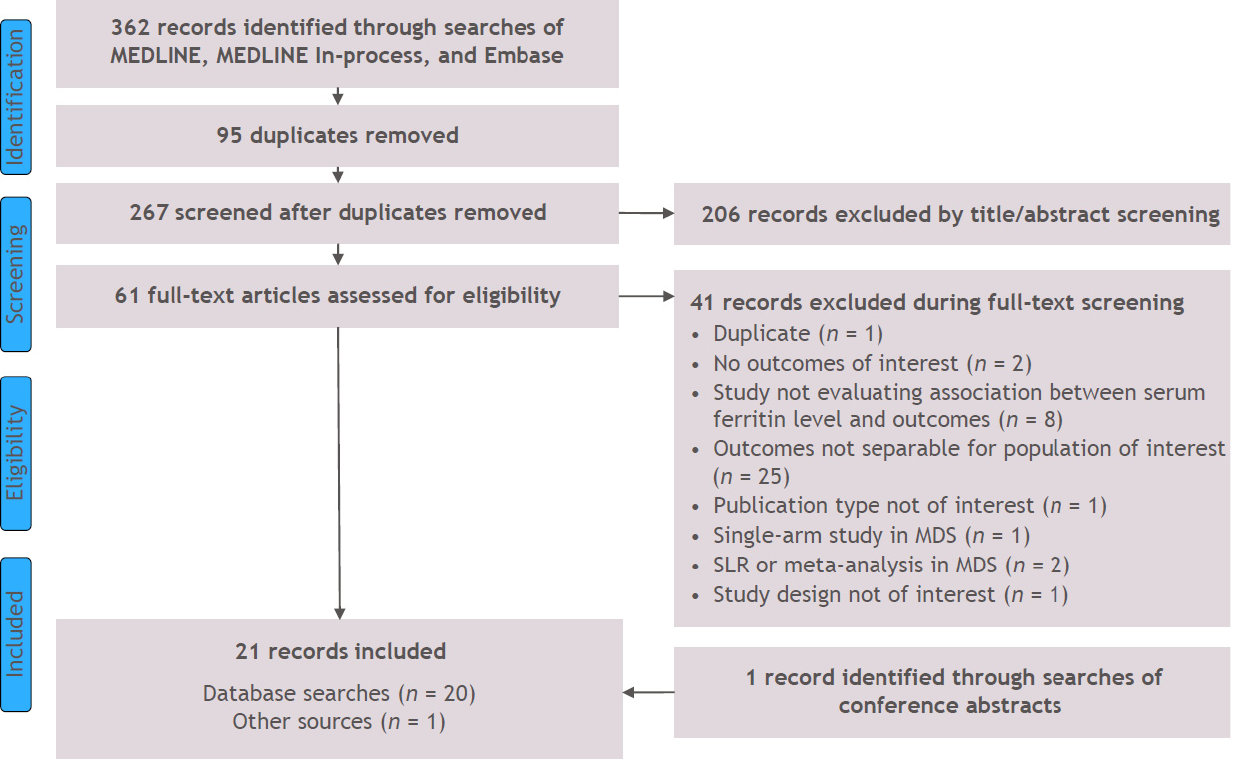
Figure 1. PRISMA diagram of study attrition for MDS studies. Abbreviations: MDS, myelodysplastic syndromes; PRISMA, Preferred Reporting Items for Systematic Reviews and Meta-Analyses; SLR, systematic literature review.